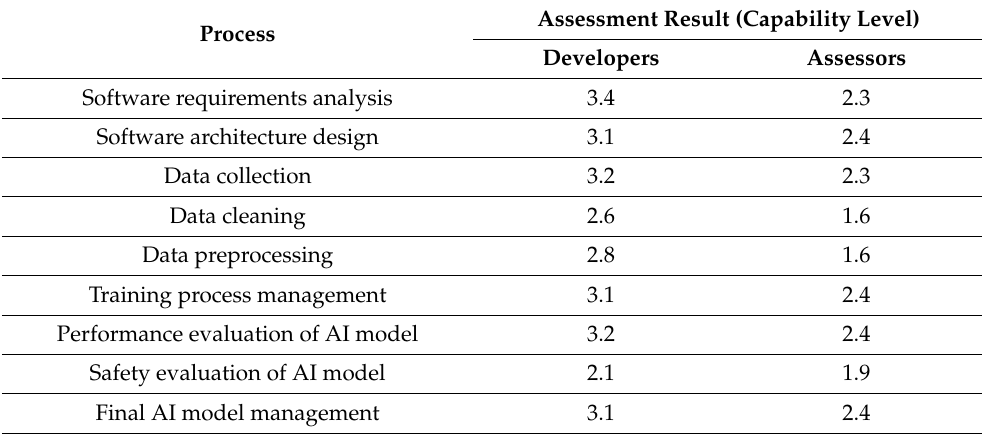
Table 7. Developers’ self-assessments vs. assessors’